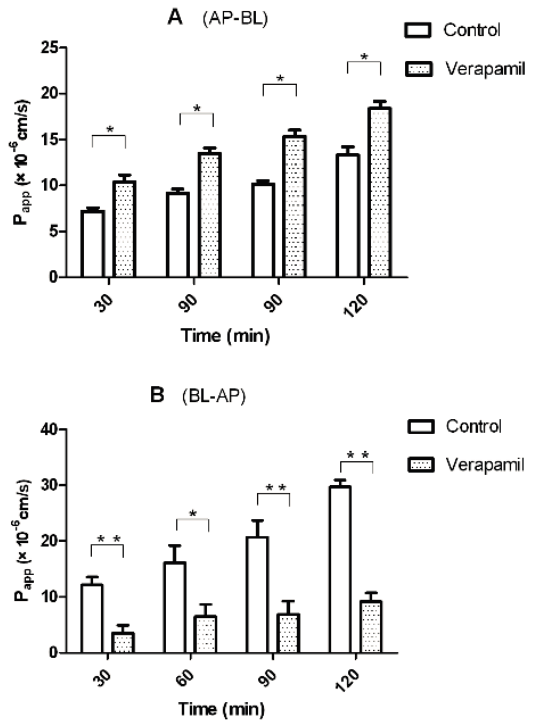
Figure 4. Effect of verapamil on the bidirectional transport of triptolide from the apical to basolateral side ( A ) or the opposite direction ( B ), Caco-2 cell monolayers were incubated at 37 °C in HBSS (pH 7.4), and triptolide (10 μ M) was added to the donor chamber of the Caco-2 cell monolayer. Verapamil (50 μ M) was added to both the donor or receiver chamber. Each point represents the mean ± SD of three determinations. * p < 0.05 and ** p < 0.01 indicate significant differences compared with the